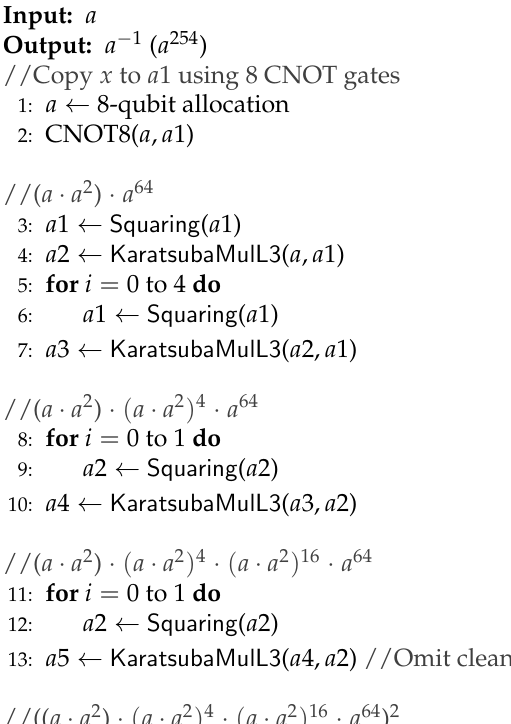
/ ( x 8 + x 4 + x 3 + x + 1 ) . 2 8